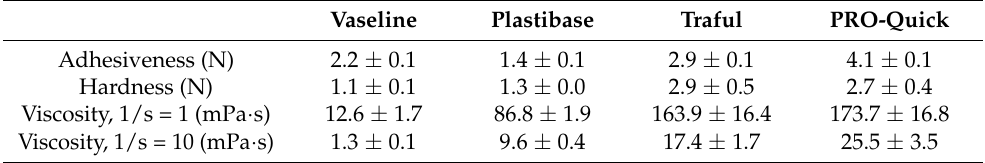
Table 1. Physical properties of ointment bases. Vaseline Plastibase Traful PRO-Quick Adhesiveness (N) Viscosity, 1/s = 1 (mPa ·